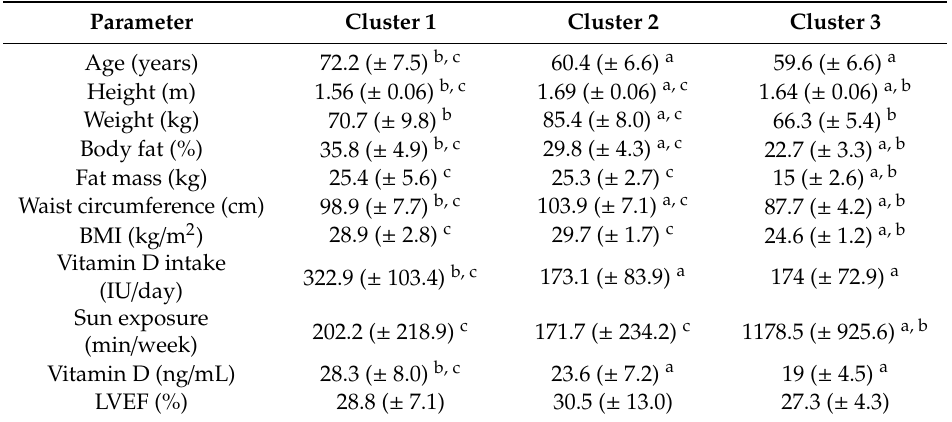
Table 2. 25(OH)D levels, lifestyle, anthropometrical, and clinical data for patients with heart failure grouped into three clusters according to the PCA analysis.